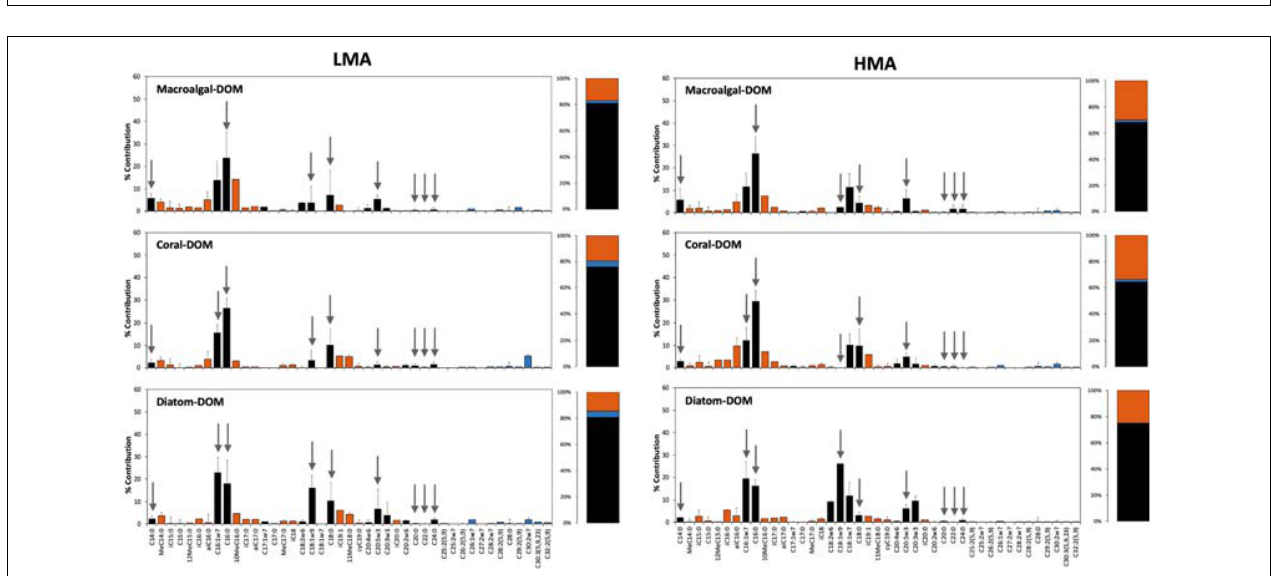
FIGURE 3 | Phospholipid fatty acid (PLFA) profiles of the sponge species used in this experiment. (A) Halisarca caerulea , (B) Haliclona vansoesti , (C) Scopalina ruetzleri , (D) Chondrilla caribensis , (E) Ectyoplasia ferox, and (F) Plakortis angulospiculatus . LMA species on the left-hand side and HMA species on the right-hand side. Values presented as the percentage contribution to the total PLFA composition. Stacked barplots depict the total percentages of bacteria- (red), sponge-specific (blue) and other (black) PLFAs within the PLFA profiles of each species. Data presented as mean (%) ± SD ( n = 3 ).